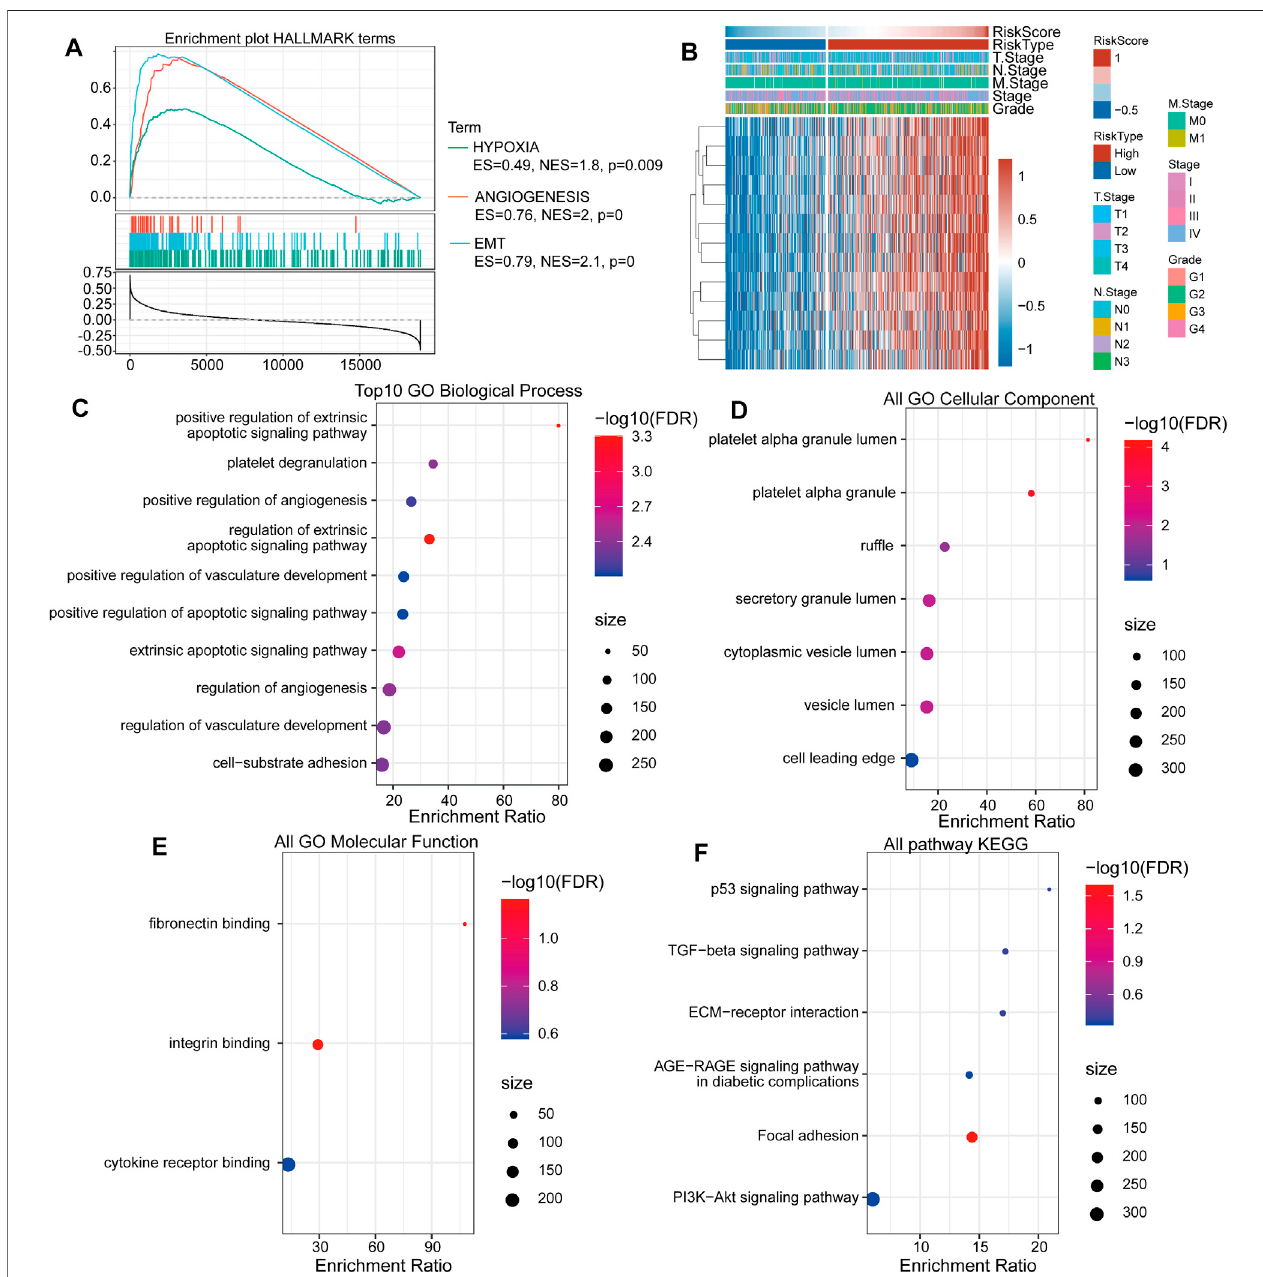
FIGURE 5 | The TGF- β pathway gene-based high-risk score subgroup is related to tumor-associated biological signaling pathways. (A) The “ HALLMARK ” term enrichment plot between the high- and low-risk score subgroups. (B) The heat map shows the most correlating gene expression levels in the subgroups. (C) The enrichment ratio of the top ten gene ontologies through GO-BP analysis. (D) The enrichment ratio of the top ten gene ontologies through GO-CC analysis. (E) The enrichment ratio of the top ten gene ontologies through GO-MF analysis. (F) The enrichment ratio of the top ten gene ontologies through KEGG